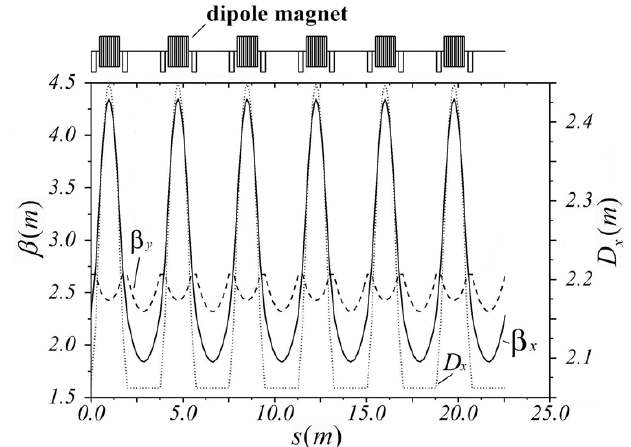
FIG. 8. Beta functions as a function of the position s . In this case deflection elements are used as conventional dipole mag-